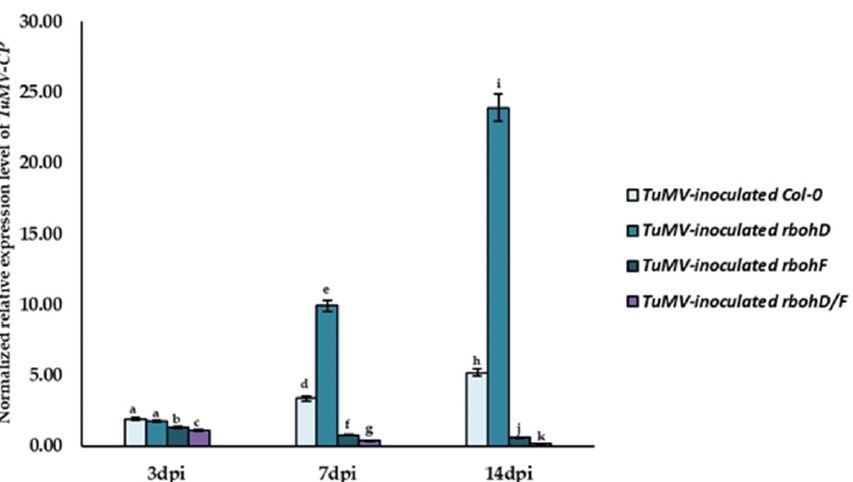
Figure 1. Validation of TuMV levels in Col-0, rbohD , rbohF , and rbohD/F plants at 3, 7, and 14 dpi based on normalized relative expression of TuMV-CP . Normalized relative expression of TuMV-CP was calculated based on the mean expression of AtEf1 α and AtF-Box reference genes. Statistical significance of differences was assessed at the p < 0.05 level using ANOVA with post hoc Tukey’s HSD and is indicated by different letters above the